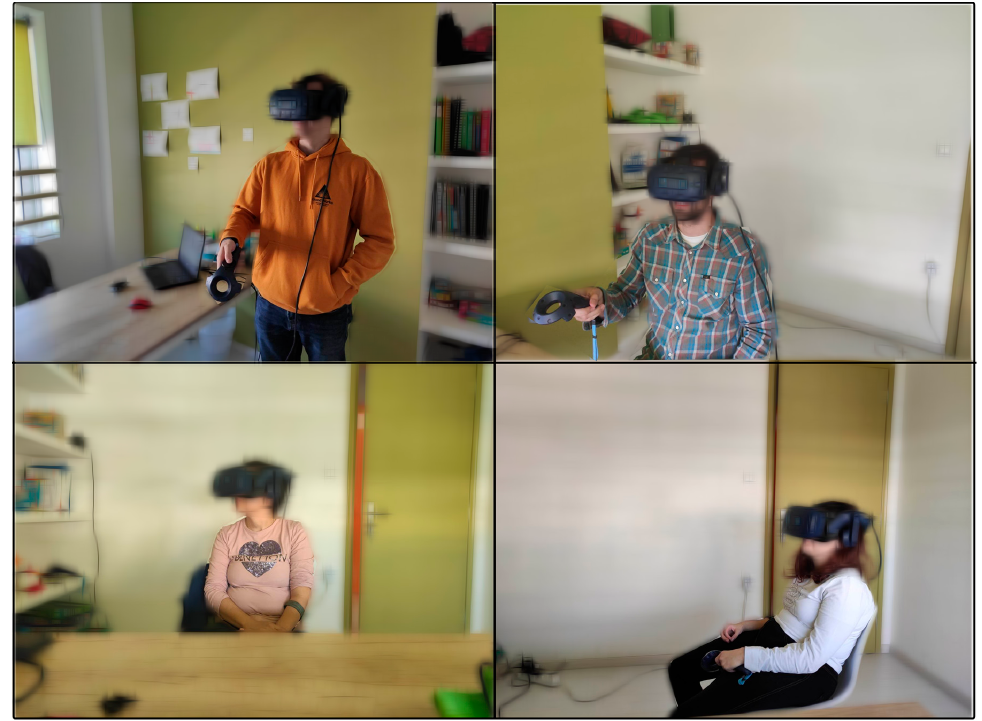
Figure 8. Participants performing the VR social scenarios in a standing or sitting position. Images are blurred to prevent the identi fi cation of participants.